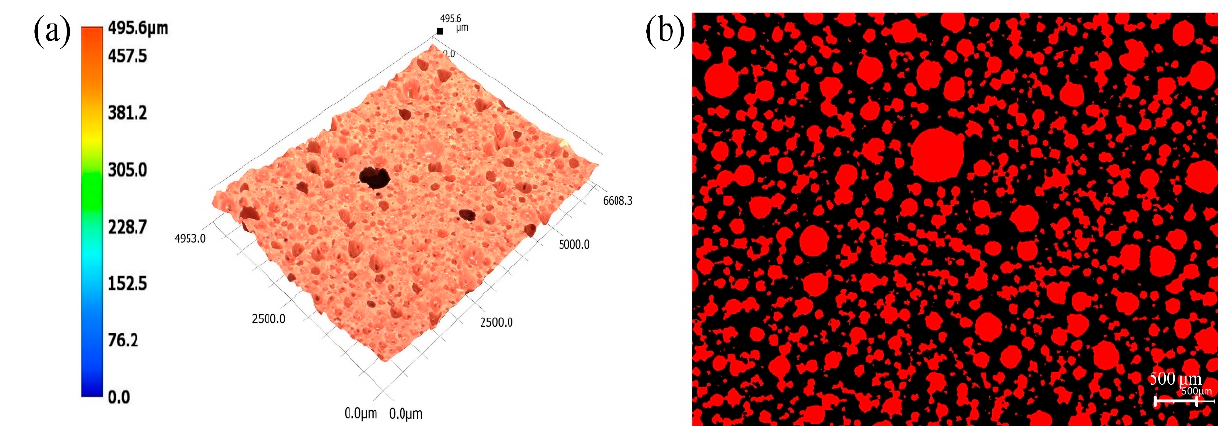
Figure 2. Surface morphology of polishing pad: ( a ) 3D morphology, ( b ) pore distribution.